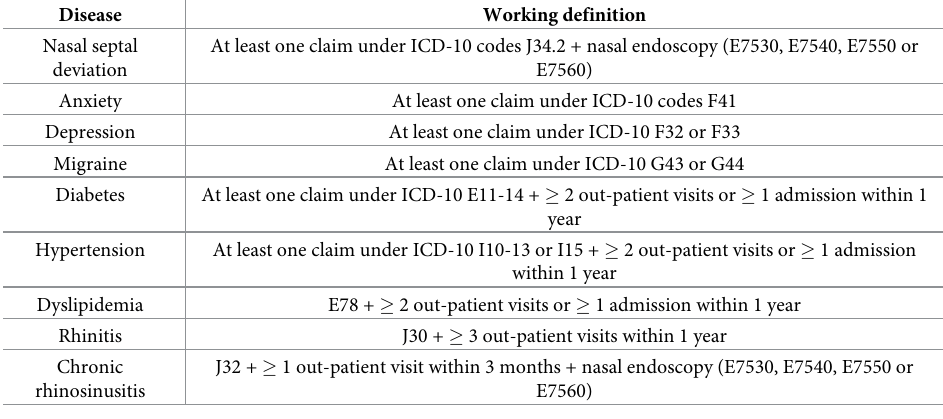
Table 1. Working definition derived from the NHIS claim